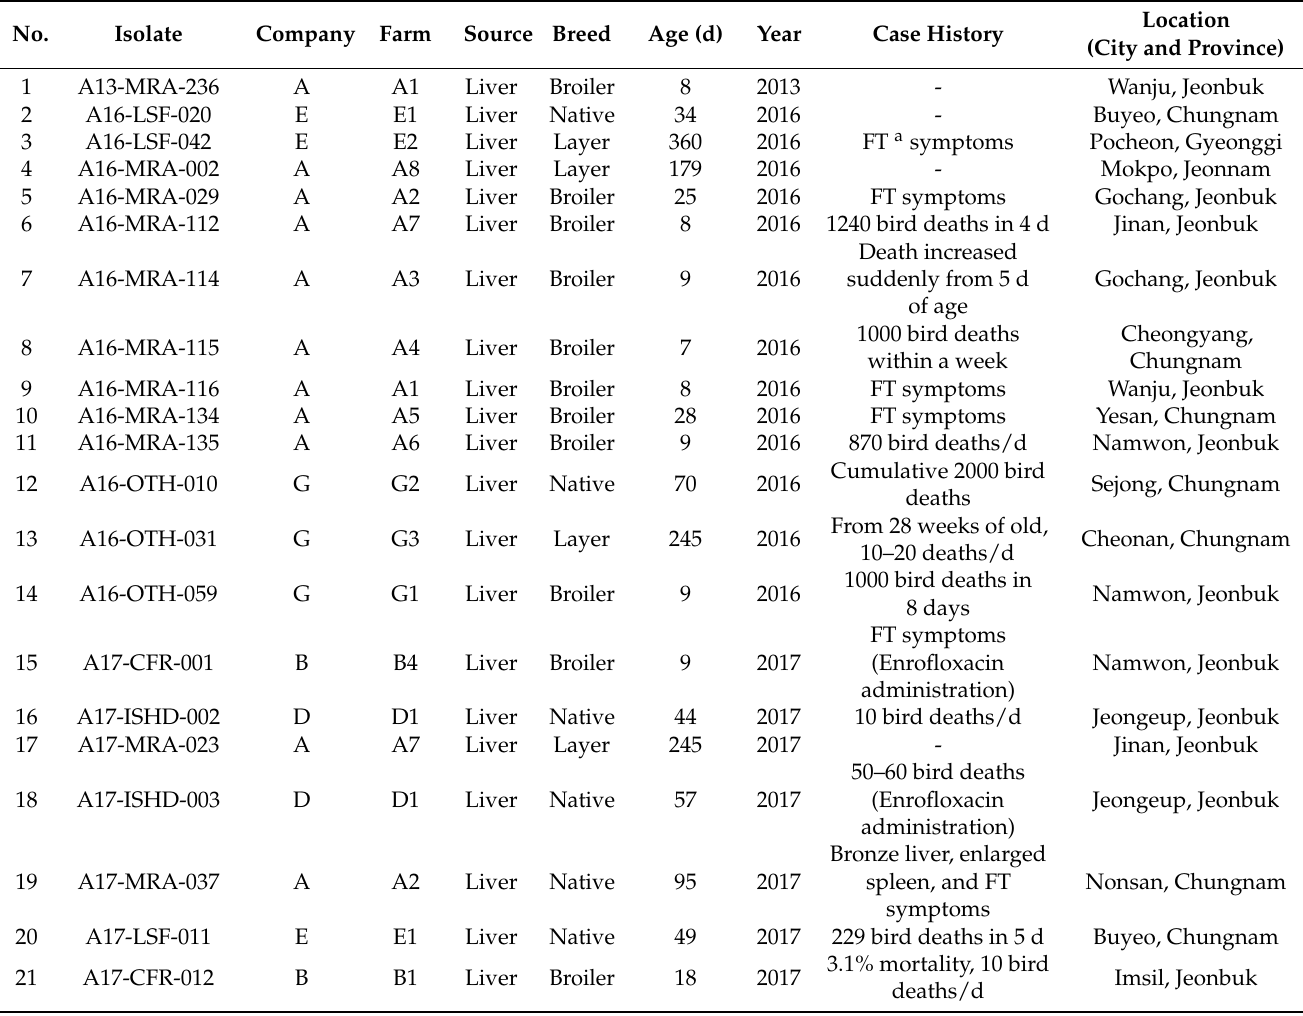
Table 1. Isolates of S. enterica ser. Gallinarum used in the present